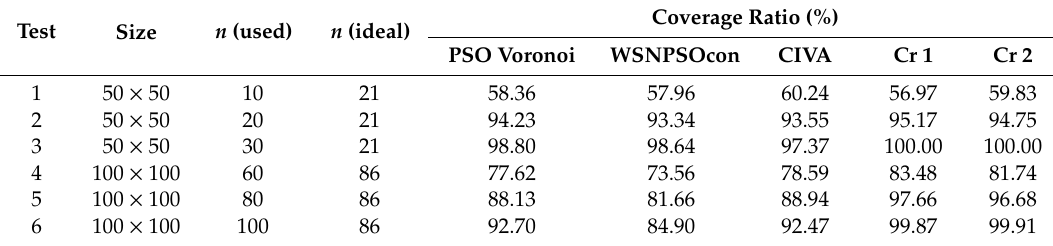
Table 2. Comparison of the coverage ratio of the four deployment algorithms in six tests.